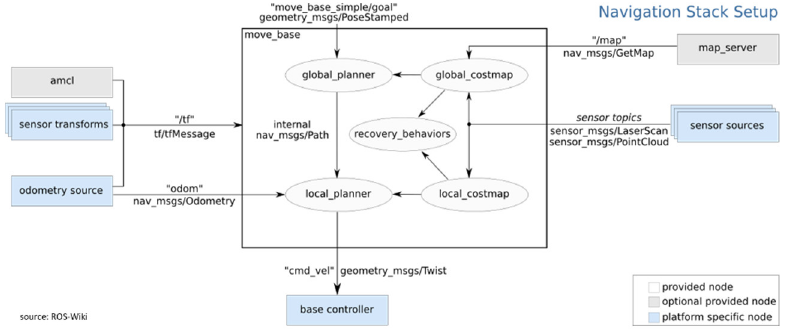
Figure 8. The Robot Operating System (ROS) navigation stack.